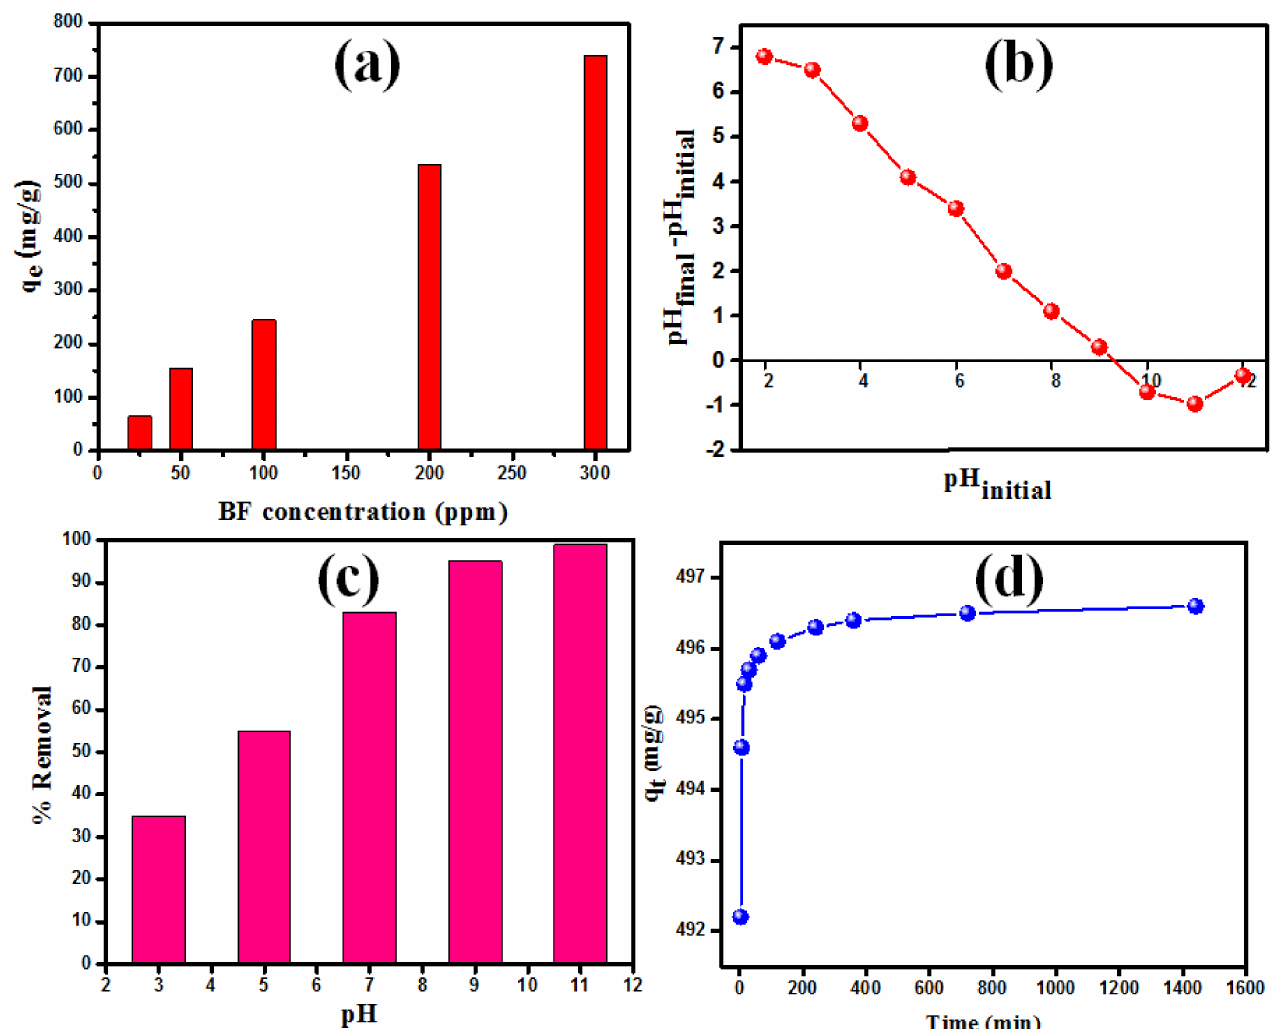
Figure 4. ( a ) Effect of initial BF dye concentration on the adsorption on MgO at pH = 7, ( b ) plot for the determination of pHZPC of MgO, ( c ) the influence of pH on % elimination of BF with an initial concentration of 200 ppm, and ( d ) equilibrium time study with a BF starting concentration of 150